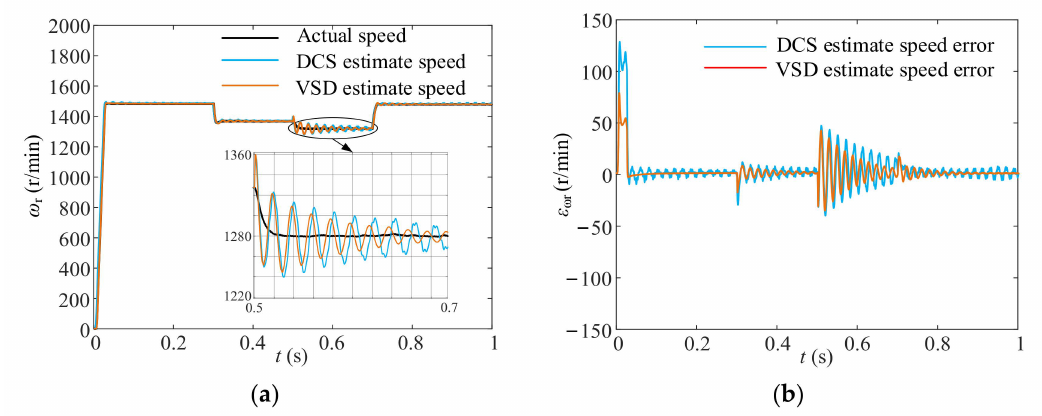
Figure 19. Speed-estimation results with stator resistance identification. ( a ) Speed; ( b ) Speed